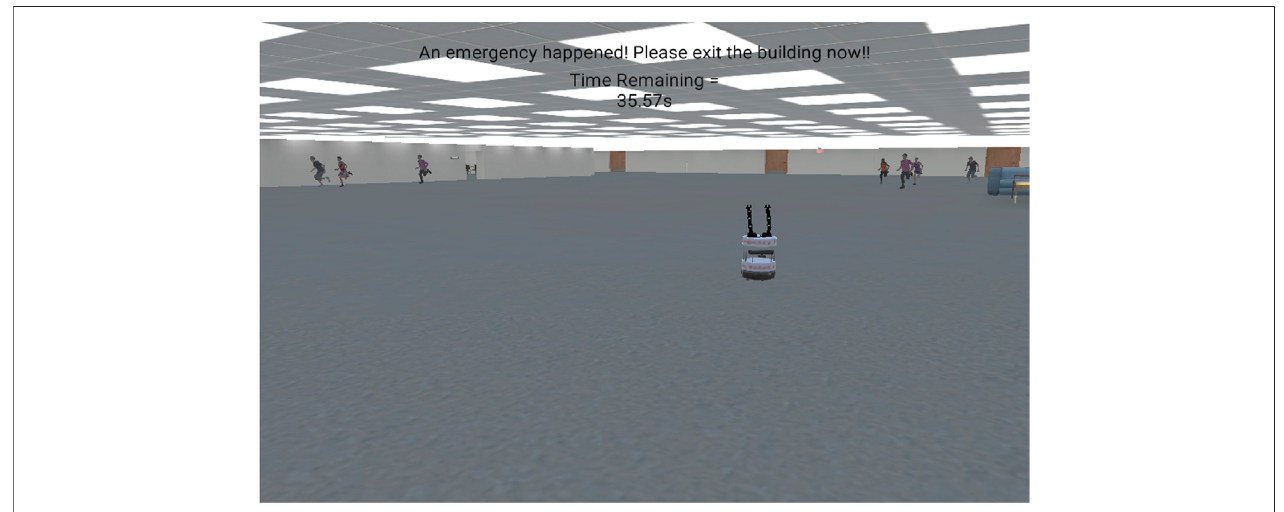
FIGURE 5 | A sheperding robot guiding an evacuee to an exit. The robot travels in front of the evacuee all of the way to the exit.